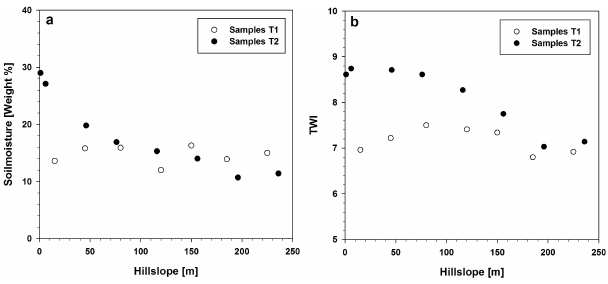
Fig. 7. Mean gravimetric soil moisture in weight % (a) and TWI (b) along the study hillslope transects (T1 and